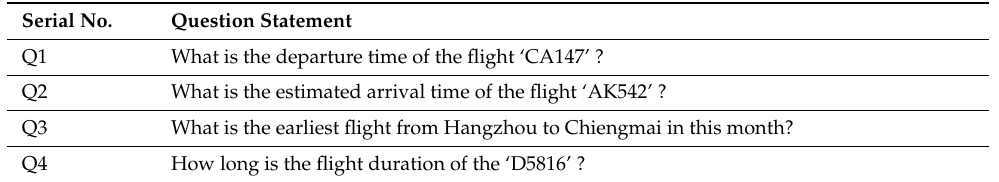
Table A1. An overall list of questions provided in the task